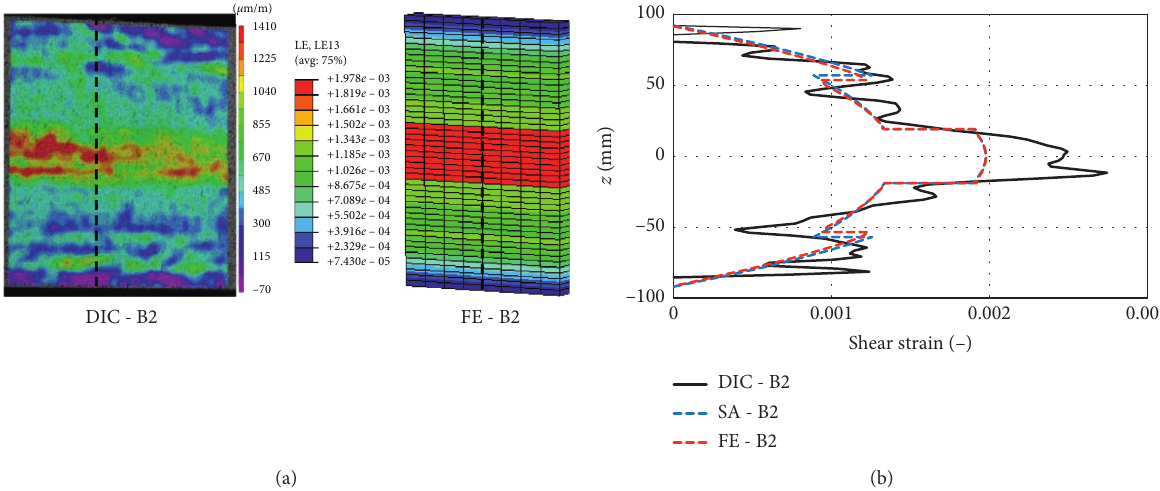
Figure 12: Colour contour plots and shear strain distribution from bending tests for